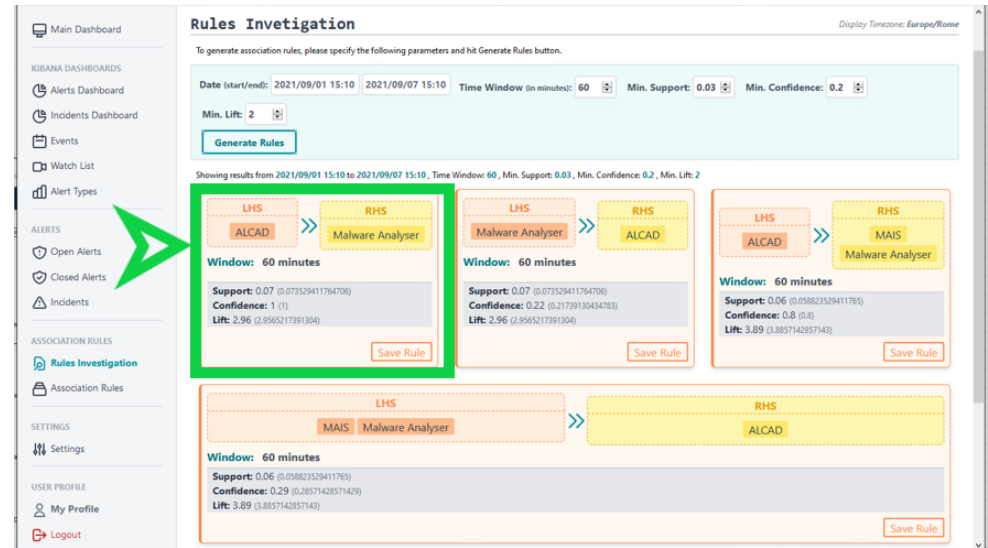
Figure 26. Association Rules generated by SMS-I tool. The rule marked is the one generated by the example